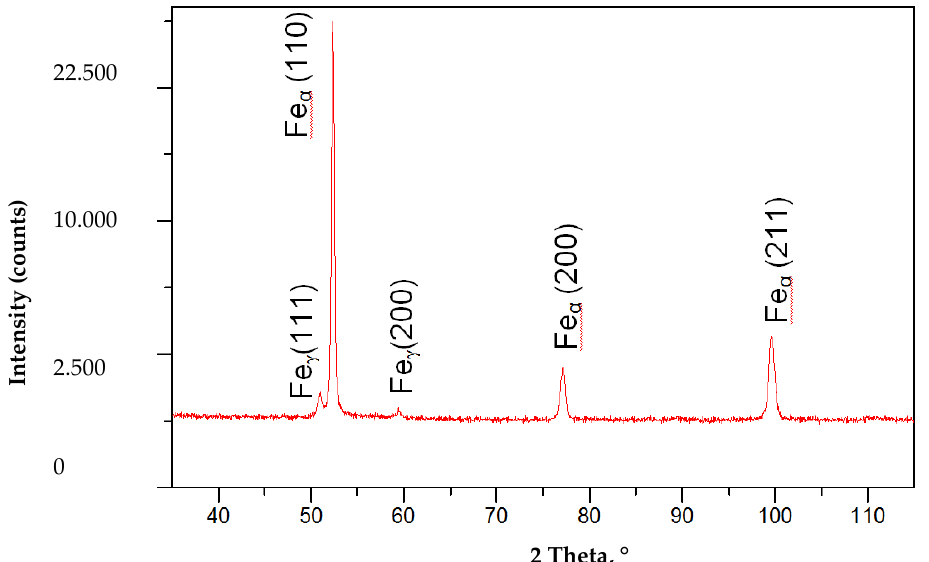
Figure 14. X-ray di ff raction of a MAG S700MC steel butt joint welded with 8 kJ / cm linear energy.